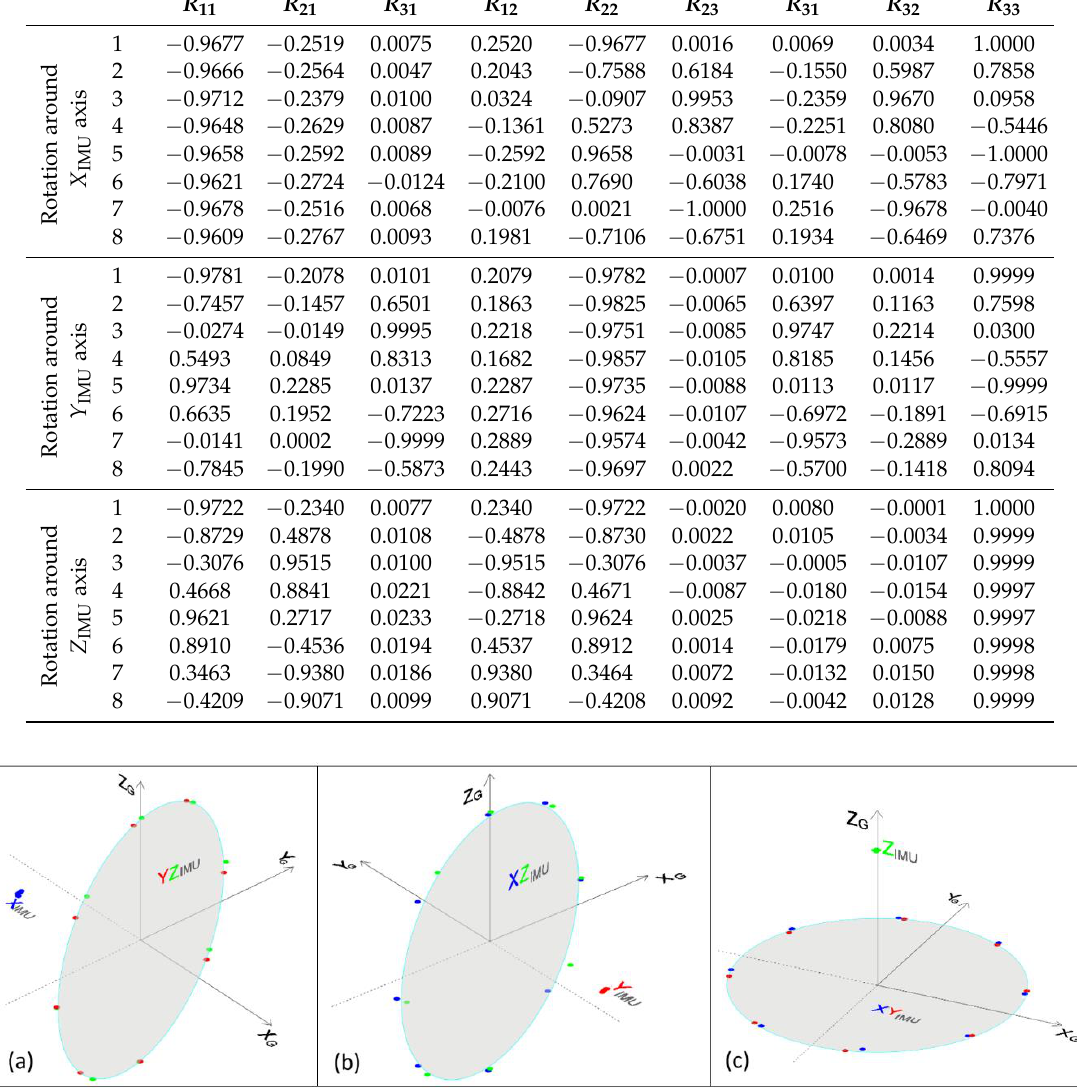
Figure 11. Unit vector coordinates of the IMU’s axes as to the ground reference system.